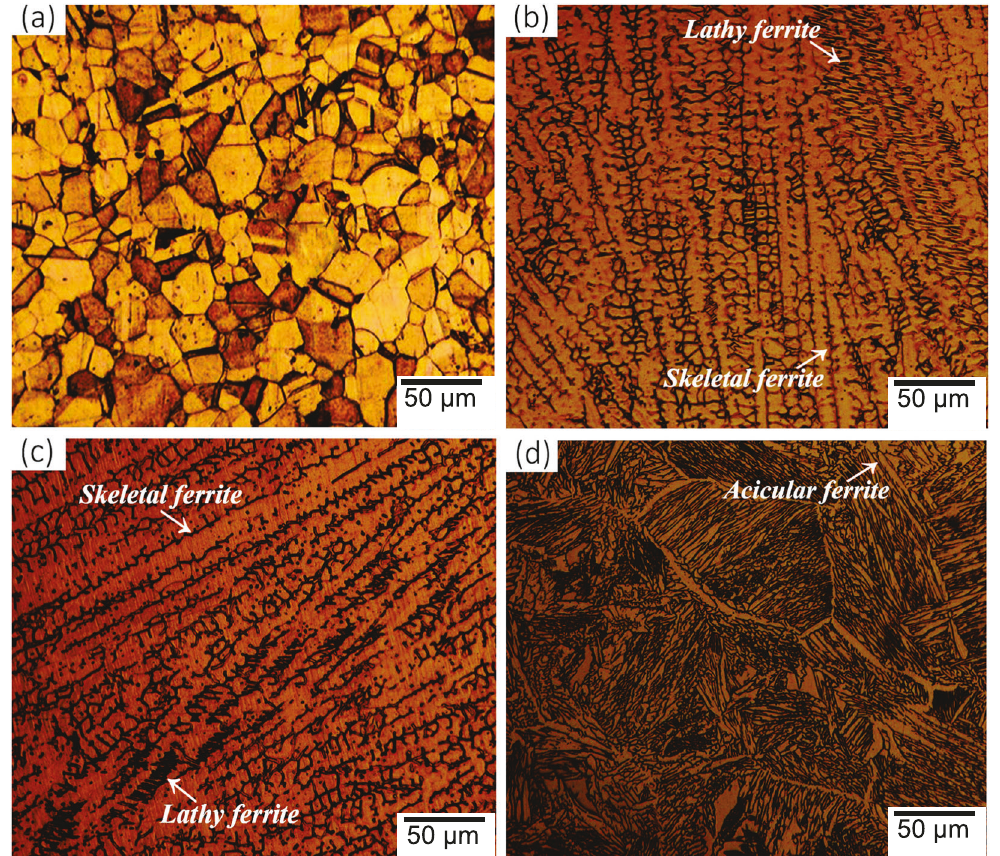
Fig. 1 Microstructure. LOM micrograph of electro-etched ( a ) AISI 316-BM. b 316L-WM. c 309L-WM. d